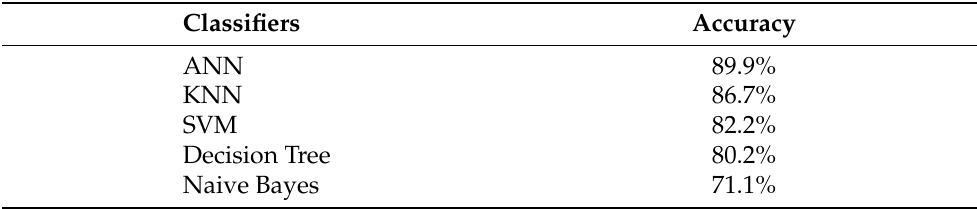
Table 1. Comparison table of accuracy for five tested classifiers: Artificial Neural Network (ANN), K-Nearest-Neighbors (KNN), Support Vector Machines (SVM), decision tree, and naive Bayes. The accuracy is evaluated on the validation set.